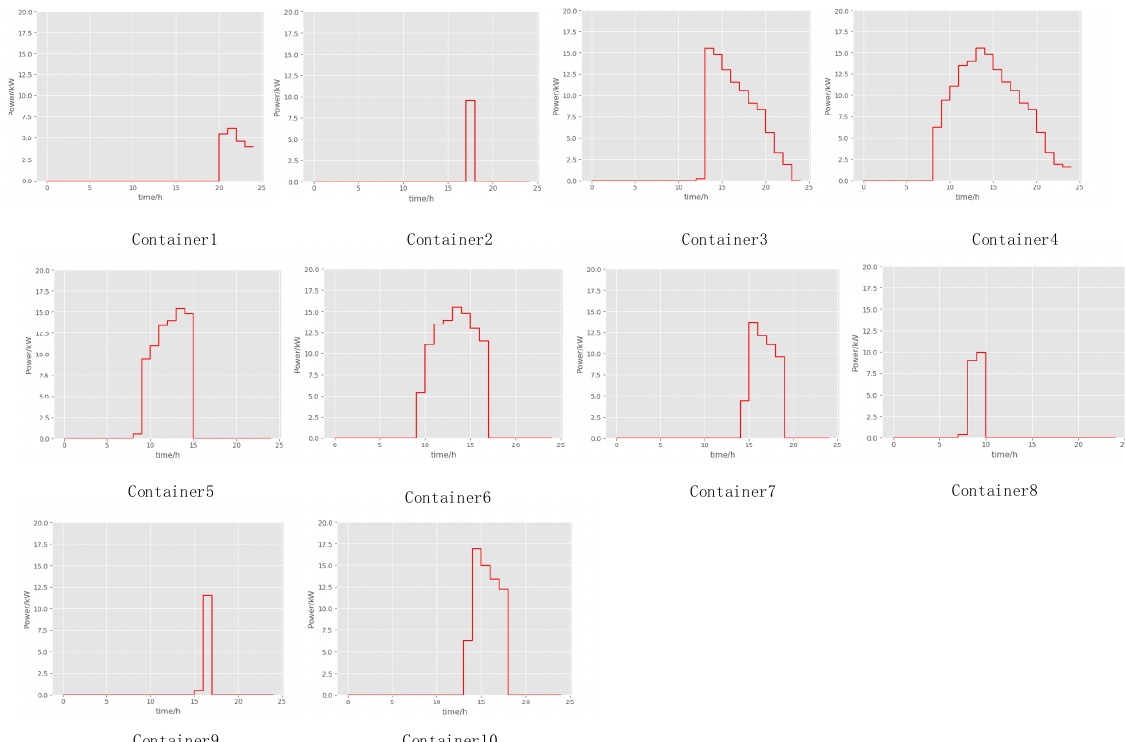
Figure 6. Emergency control strategy of containers.